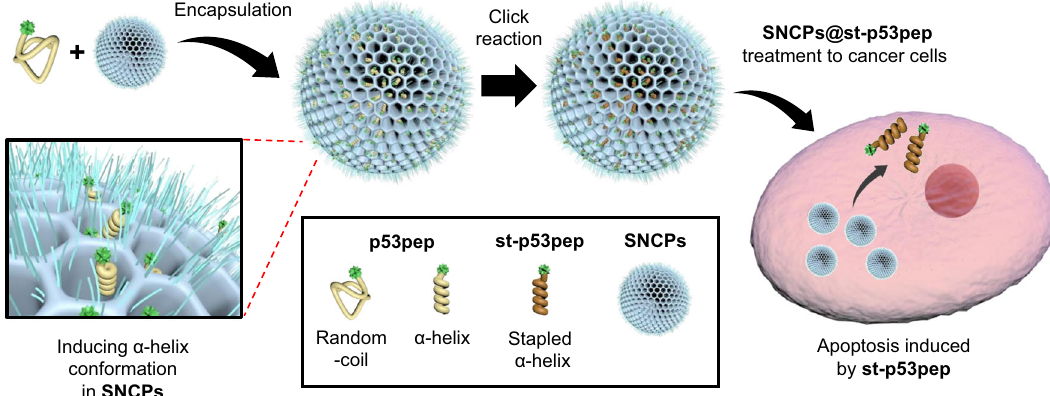
Fig. 1 | Schematic representation of synthetic nano-chaperones for peptide (SNCP)basedonporousnanoparticles. Afterencapsulationofp53pep,structural stabilization of p53pep is induced from a random-coil structure to an α -helical structure. In situ click reaction for peptide stapling then proceeds while p53pep is